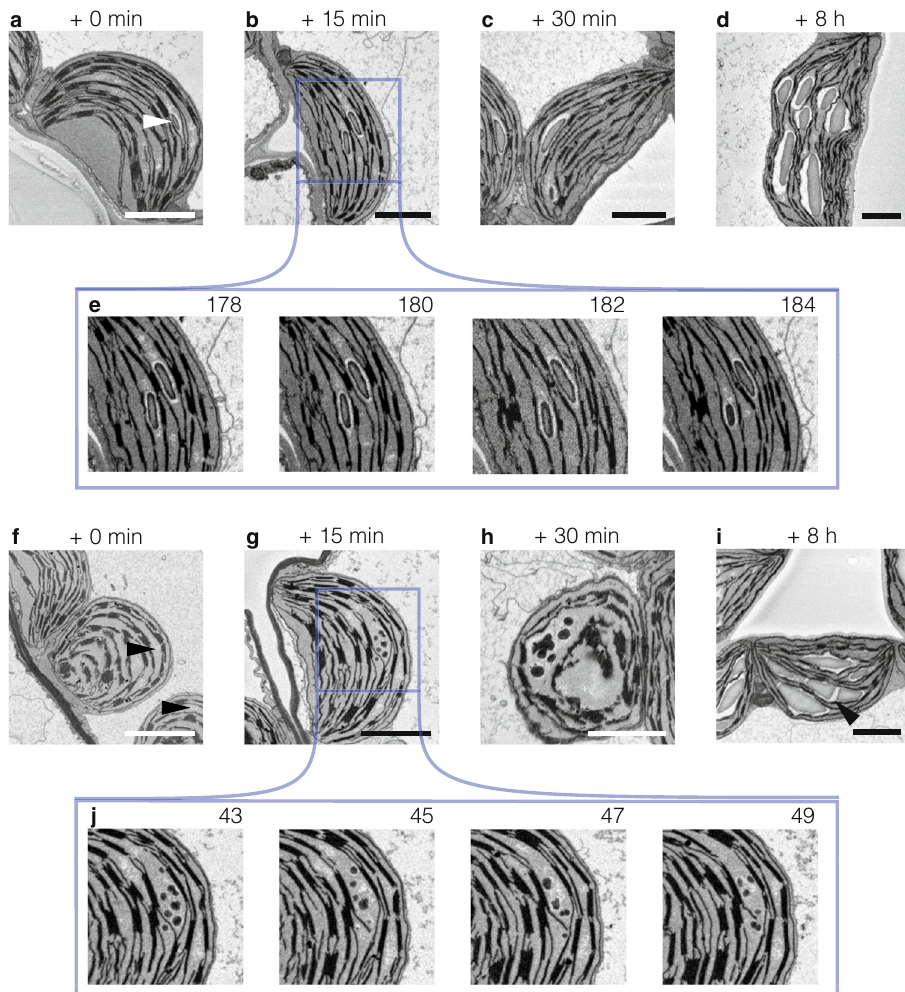
Fig. 1 De-starched chloroplasts exhibit parallel initiation of starch granules shortly after dawn. Chloroplast sections from an SBF-SEM stack (with 50- nm Z-resolution, inverted SEM images) sampled from the mesophyll of fully expanded leaves of 35-day old Arabidopsis plants grown in a 12 h:12 h diel regime. Starch granules appear as dark-gray disks between thylakoid membranes. a – d Representative chloroplast sections from plants harvested ( a ) at the end of a regular 12-h night, with a remaining starch granule (white arrowhead), ( b ) after 15 min light, ( c ) after 30 min light, and ( d ) after 8 h light. e Series of images (with 100-nm steps in the Z axis) from the sample stack in b . f – i Representative chloroplast sections from plants exposed to a prolonged night and harvested ( f ) at the end of the 4-h night extension; arrowheads indicate stromal spaces with a fl occular appearance ( g ) after 15 min light, ( h ) after 30 min light, and ( i ) after 8 h light; arrowhead indicates parallel surfaces of abutting granules. j Serial sections (with 100-nm steps in the Z axis) from the sample stack in g . Note the numerous starch initials. Scale bars: 2 µ m. Further data are given in Supplementary Fig. 1 and Supplementary Movies 1 –